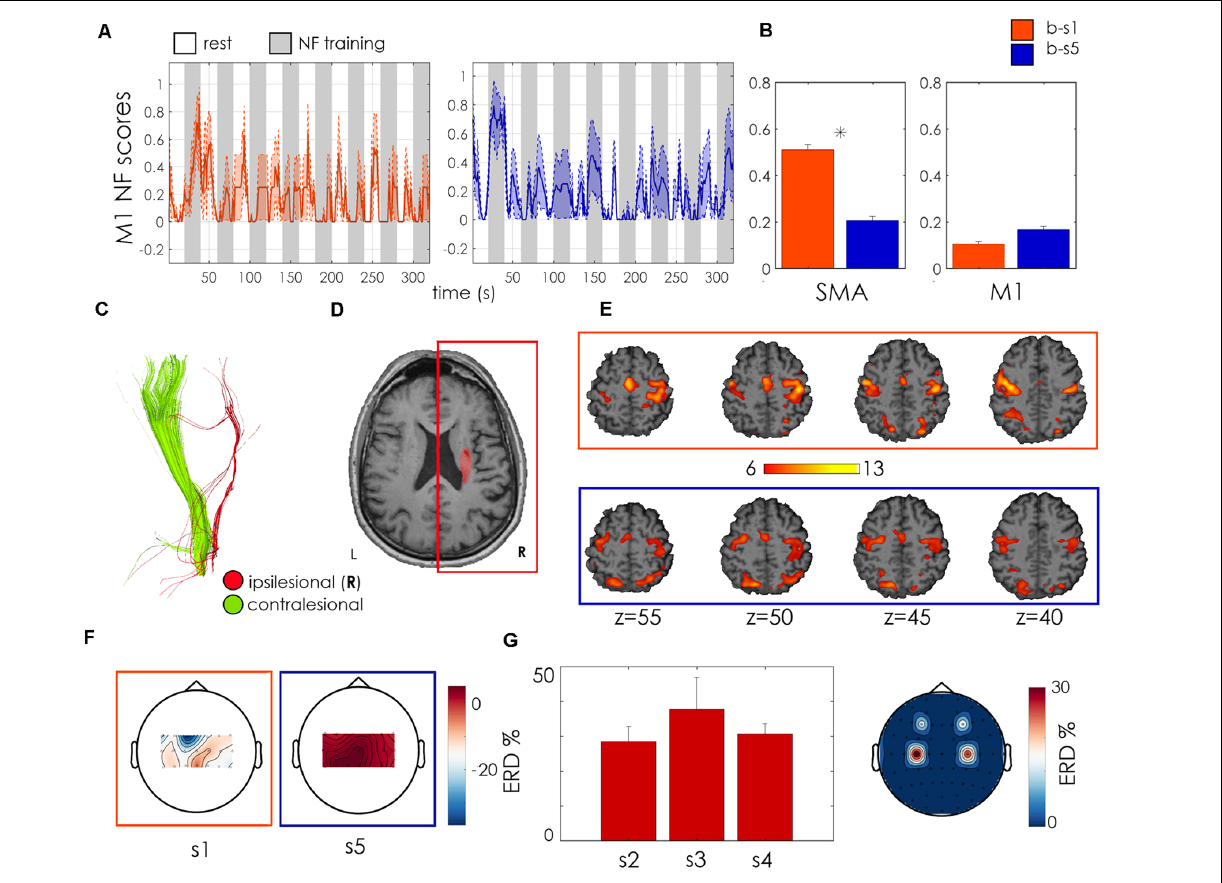
FIGURE 4 | Patient P01 outcome measures. (A) M1 regulation during NF training: Normalized NF scores as showed to the patient (mean + standard error across NF sessions—NF1, NF2, NF3- for sessions b-s1 (orange) and b-s5 (blue). Resting blocks are indicated in white, NF training blocks in gray. (B) Bar plots of mean normalized NF scores in SMA (left bar plot) and M1 (right) with relative standard error and statistics for b-s1 and b-s5. ∗ Indicates statistically significant difference ( p < 0.01) between b-s1 and b-s5 as assessed with a Wilcoxon test across blocks of the same training session. (C) Corticospinal tract (CST) reconstruction from diffusion MRI imaging. Ipsilesional CST is represented in red and contralesional CST in green. (D) Manual Lesion Segmentation (in red) on an anatomical scan. (E) Individual contrast activation maps (NF TASK > REST, voxel-wise Family-Wise error (FWE) corrected, p < 0.05) during NF training in session b-s1 (orange) and b-s5 (blue). (F) Scalp plots of mean EEG ERD (across NF runs) in b-s1 (left) and b-s5 (right; bimodal EEG-fMRI sessions). (G) Unimodal EEG-NF outcomes: mean and standard error ERD estimated from the ipsilesional motor electrode (C4) for the three unimodal EEG-NF training sessions (left) with topoplot of the mean ERD values over motor electrodes (right). Results shown in panels (F,G) were obtained offline. For each motor channel (18 for the bimodal sessions, five for the unimodal EEG-NF runs) ERD was computed as the normalized difference in the 8–30 Hz band power (BP) between the rest block and the following training block. The mean ERD value for each channel is displayed in scalp plots representing “ERD activation maps.” For panel (G) , in order to have a synthetic view of the ERD across the three unimodal sessions, only the ERD from channel C4, the electrode corresponding to the ipsilesional M1, was